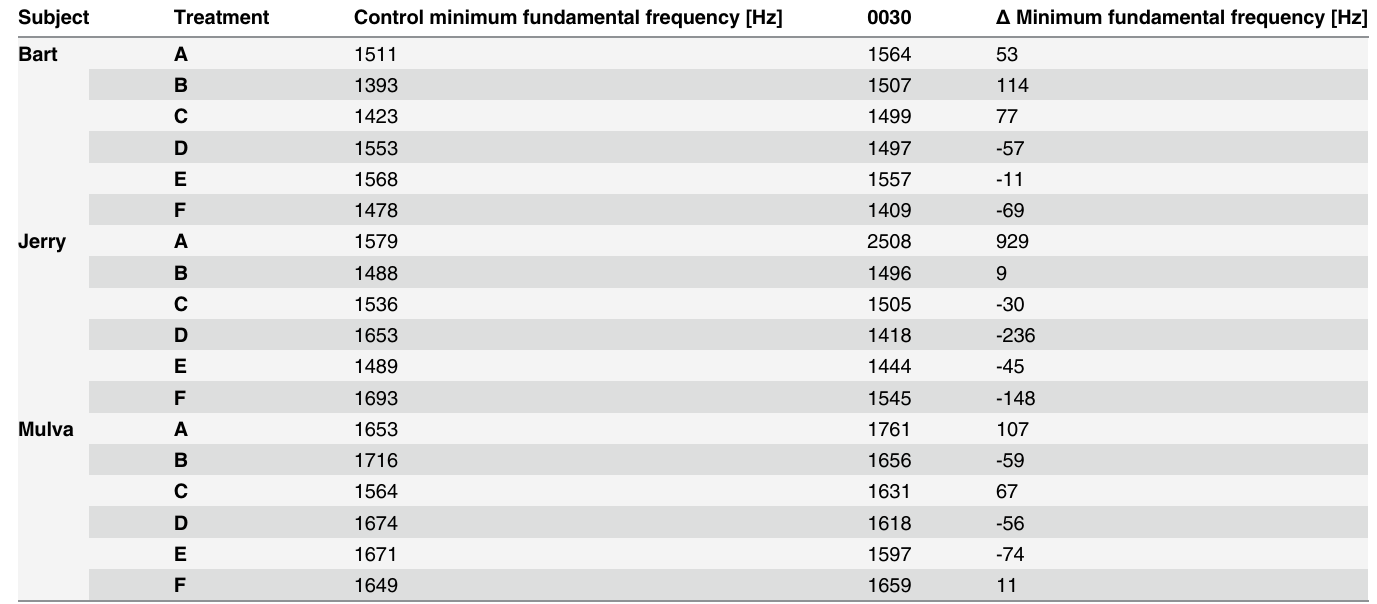
Table 4. Minimum fundamental frequency of CLCs and change with each noise